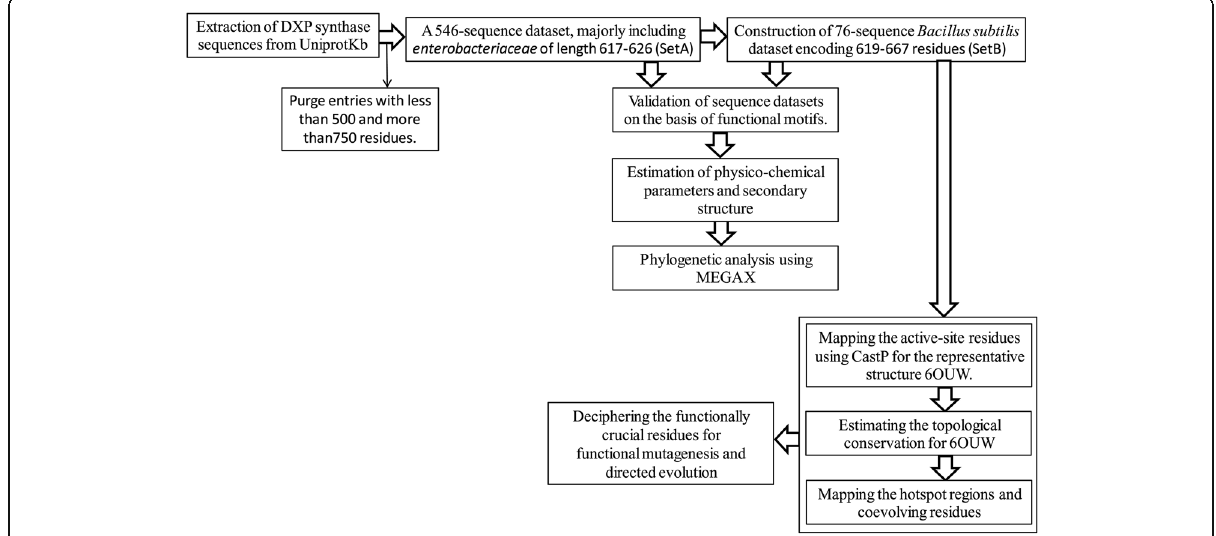
Fig. 3 Algorithmic flowchart for the analysis from sequence dataset to functional annotation and coevolving residues across the active